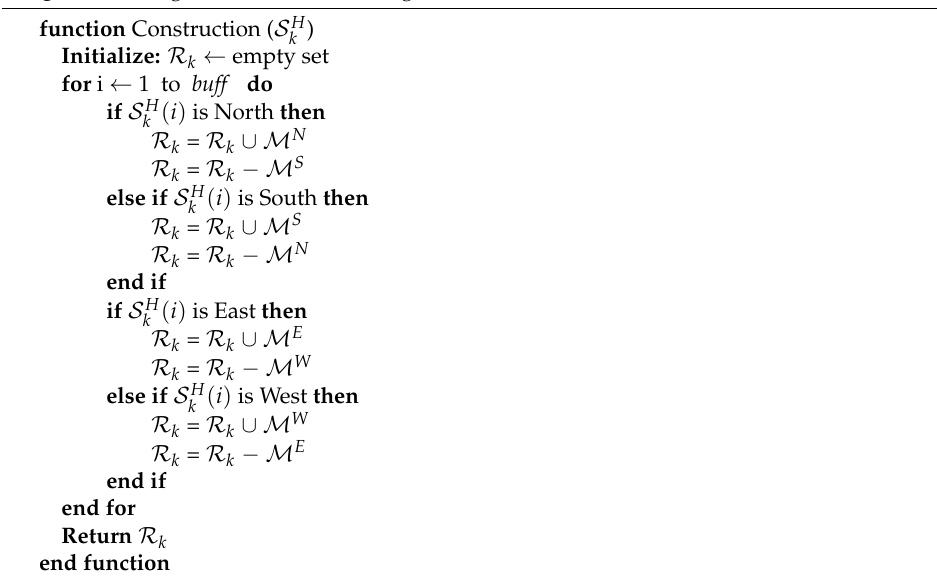
Figure 4. Examples of the map-matching process: ( a ) M and S k at k = 3; ( b ) R k and S k at k = 4; and ( c ) R k and S k at k = 4. Algorithm 1 Algorithm for constructing the